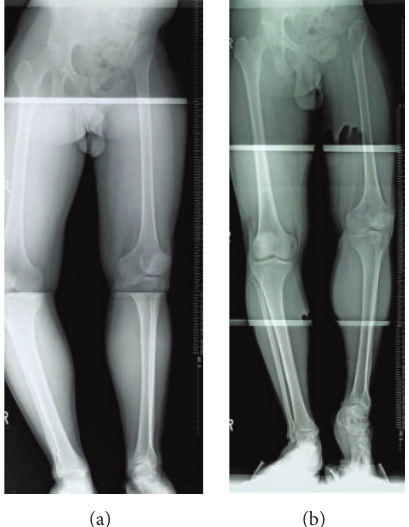
in cases involving a nearly complete resection of the half pelvis and the ipsilateral proximal femur.